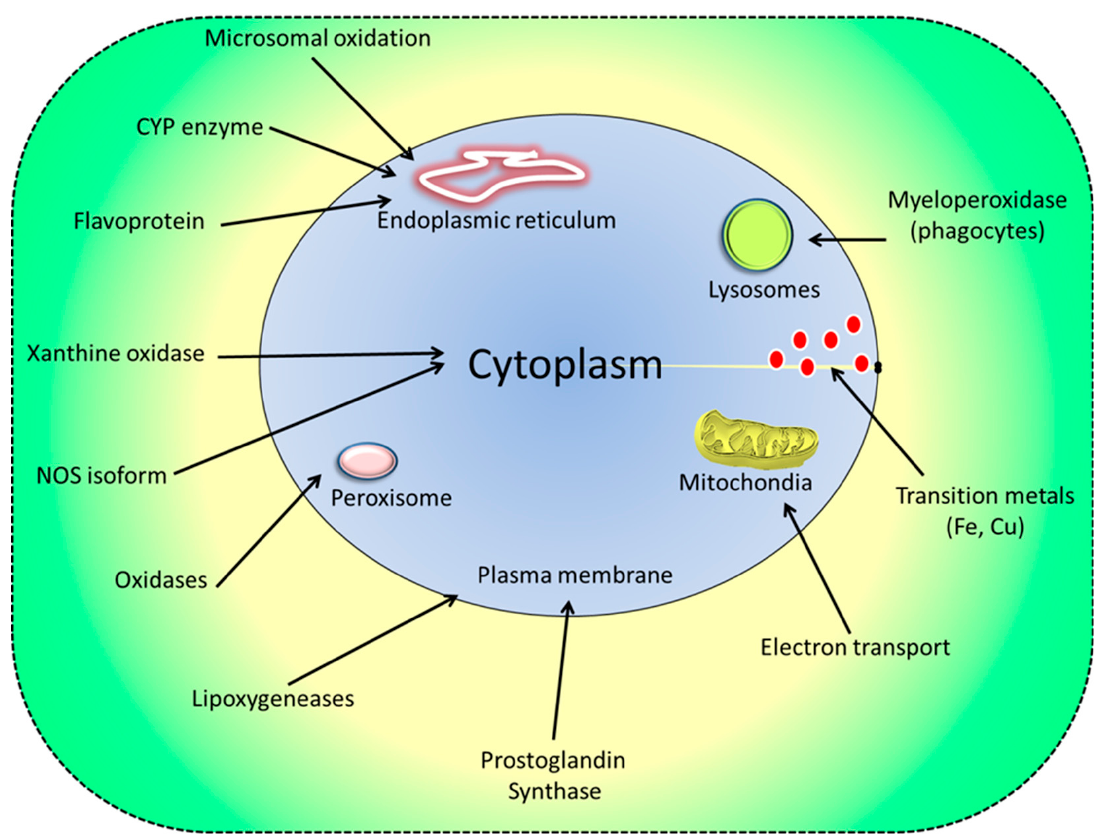
Figure 1. Endogeneous sources of ROS and RNS. Where, ROS, reactive oxygen species; RNS, reac- tive nitrogen species; CYP, cytochrome; NOS, nitric oxide synthase.